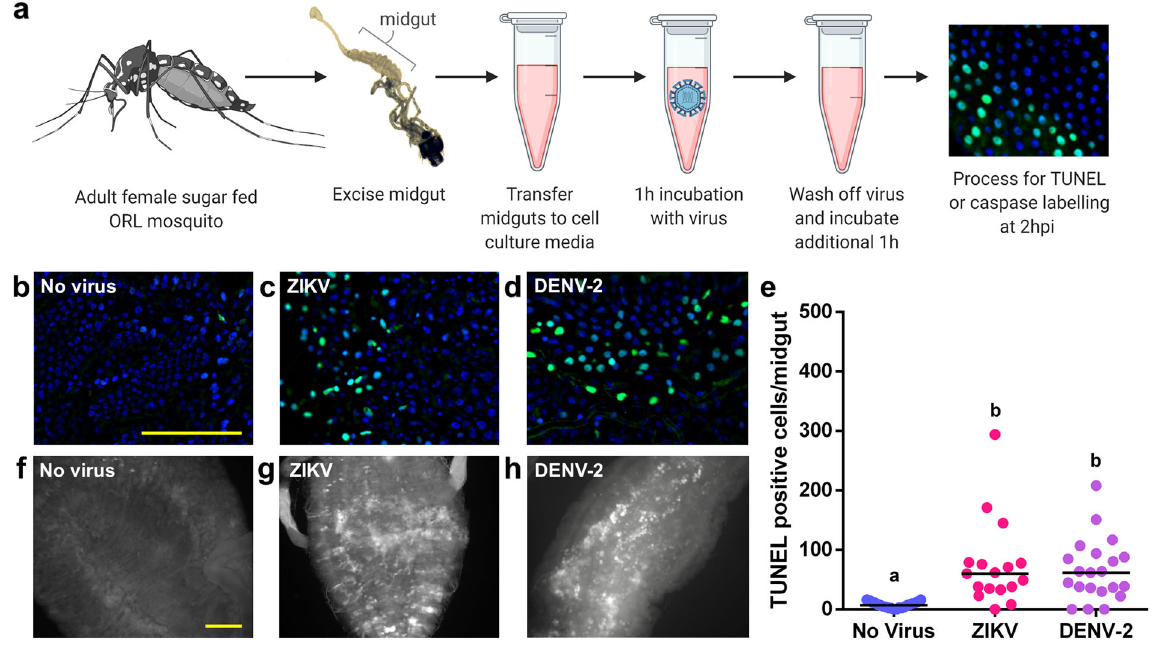
Fig. 2 Exposure to a blood meal containing DENV-2 or ZIKV induces DNA fragmentation in the epithelium of ex vivo adult female Aedes aegypti (ORL) midguts at 2hpi. a Work fl ow diagram of ex vivo midgut infection. b – d Representative images of DNA fragmentation visualized via TUNEL at 2 hours after b ex vivo mock infection, c ZIKV infection or d DENV-2 infection. e Quanti fi cation of TUNEL-positive cells per midgut at 2 hours post ex vivo infection. ( n (naive) = 21; n (ZIKV) = 17; n (DENV-2) = 18). The horizontal line indicates the median. Treatments without a common letter were found to be statistically signi fi cant ( α = 0.05) as calculated by Kruskal – Wallis test with Mann – Whitney post hoc comparison (Kruskal – Wallis chi-squared = 22.285, df = 2, p value = 1.448e-05). f – h Pan-caspase activation at 2 hours after f mock infection g ZIKV infection or h DENV-2 infection. Scale bars shown are 100 µ m in length and can be applied to all related